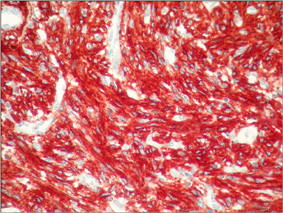
In microscopic appearance of immunohistochemical analyses, CD117   immunoreactivity is shown as diffuse strong cytoplasmic staining in spindle   cell (CD117 immunostain, W200).